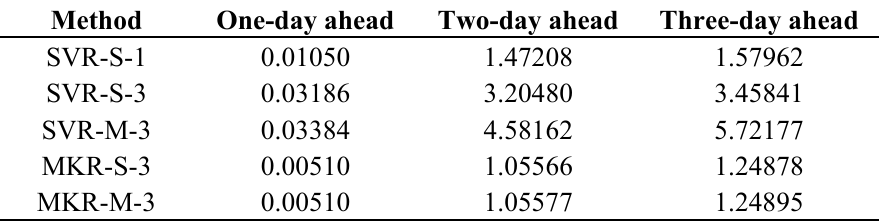
Table 6. Standard deviation of RMSE/mean for WTI Crude oil price prediction (total 14 experiments).